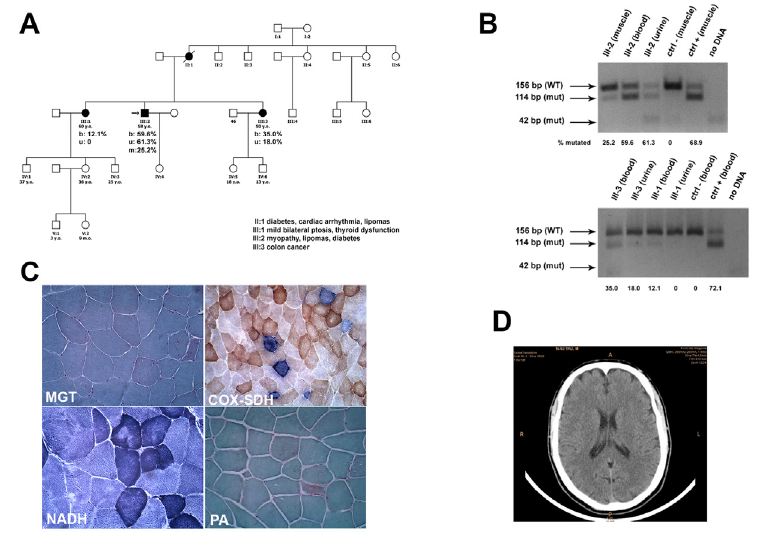
Figure 1. ( A ) Pedigree of family. ( B ) PCR-RLFP analysis of amplicons obtained from muscle, urine, and blood of the indicated subjects, electrophoresed on 4% agarose gel after BglI cut. The numbers under each lane indicate the estimated mutational load in the sample. ( C ) Morphological examination showed some RRFs at MGT, several COX-negative fibers, many of which are intensely SDH-positive (RRFs). Scale bar 50 μ m. ( D ) Brain CT scan.